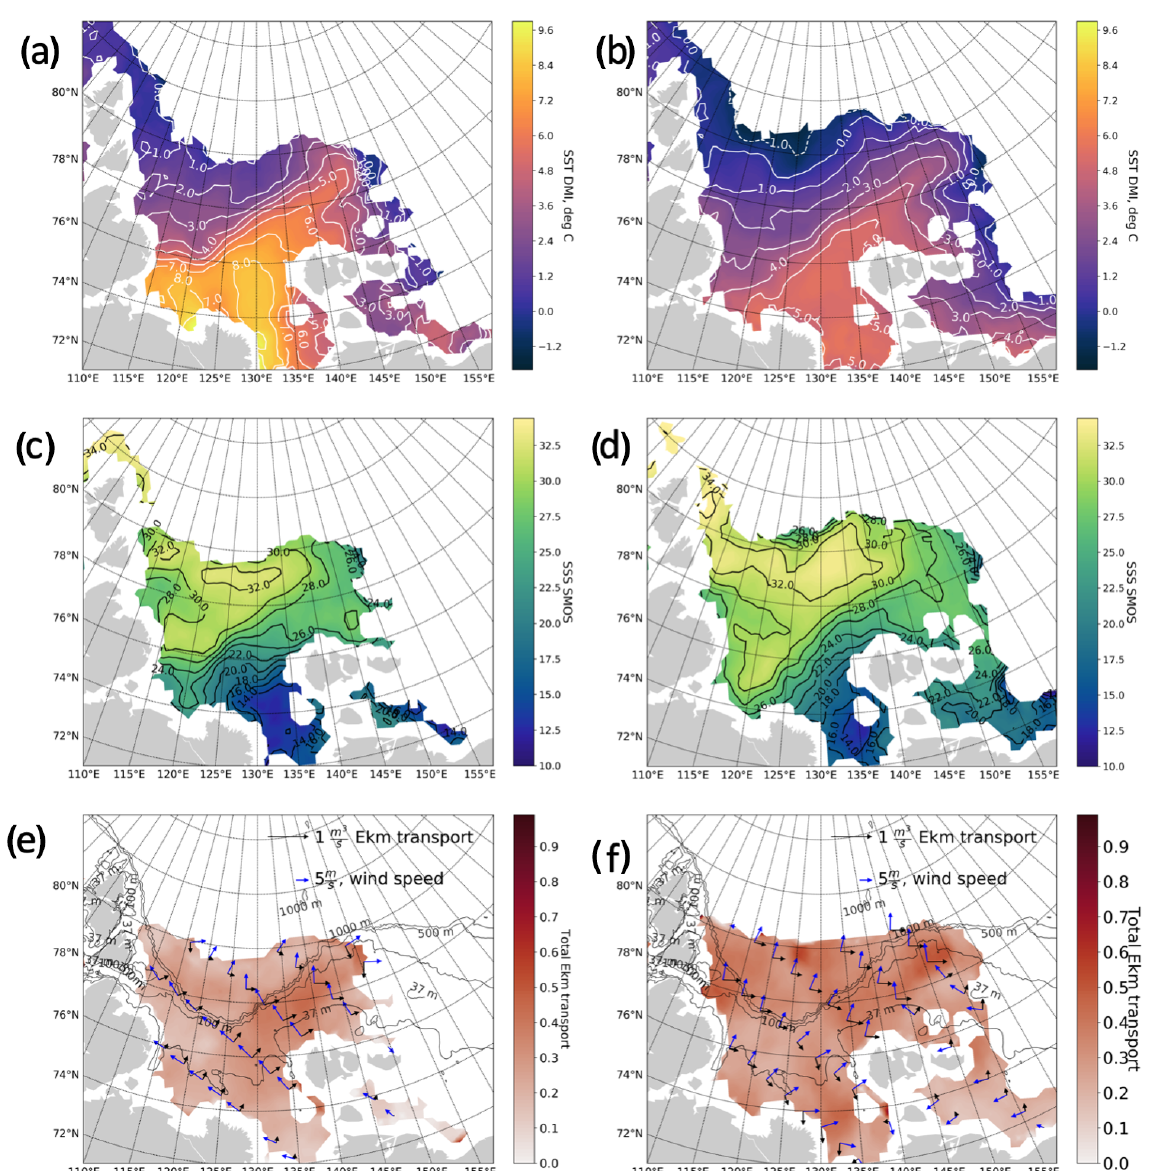
Figure 15. August (left column) and September (right column) monthly means of (a, b) SST ( ◦ C) and (c, d) SSS. Panels (e, f) show wind speed (ms − 1 ) and direction with blue arrows, horizontal Ekman transport (m 3 s − 1 ) with black arrows, and total horizontal Ekman transport is shown using color